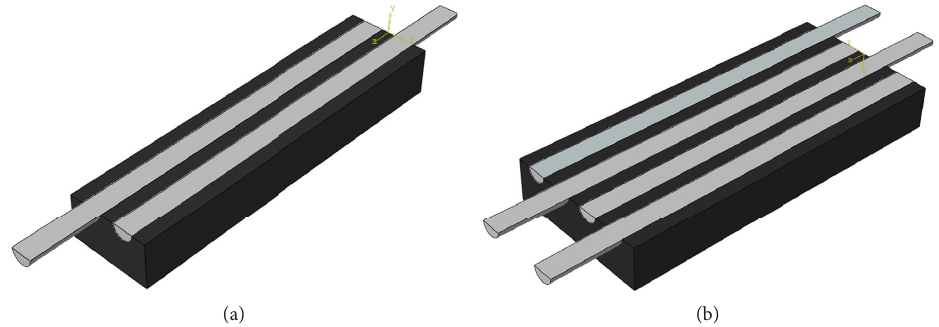
Figure 12: Model of the steel cord conveyor belt. (a) Two steel cords. (b) Four steel cords.